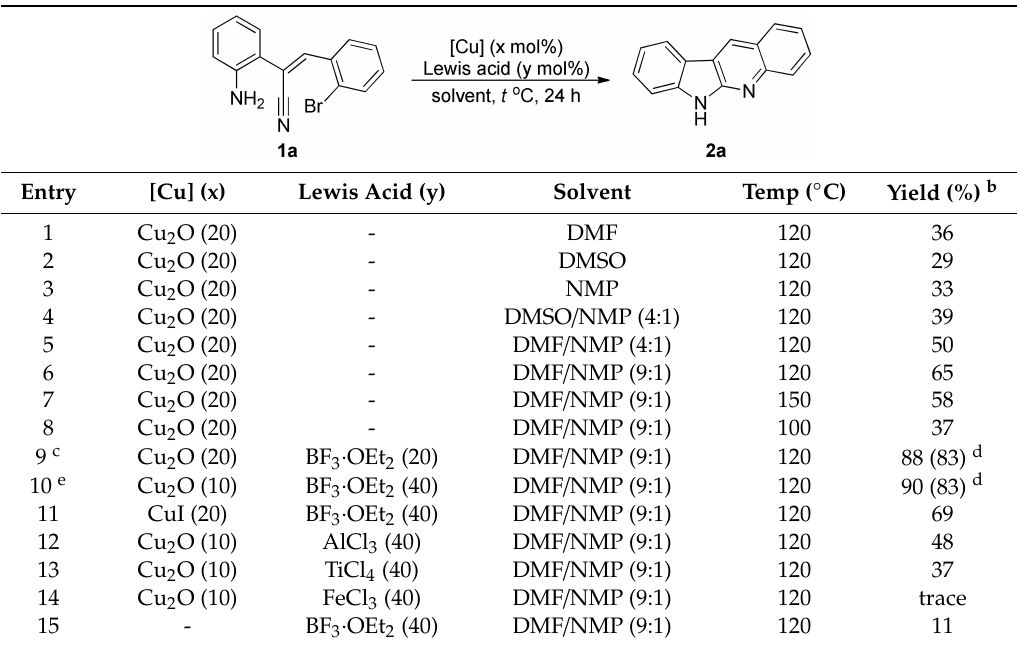
Table 1. Optimization of reaction conditions a